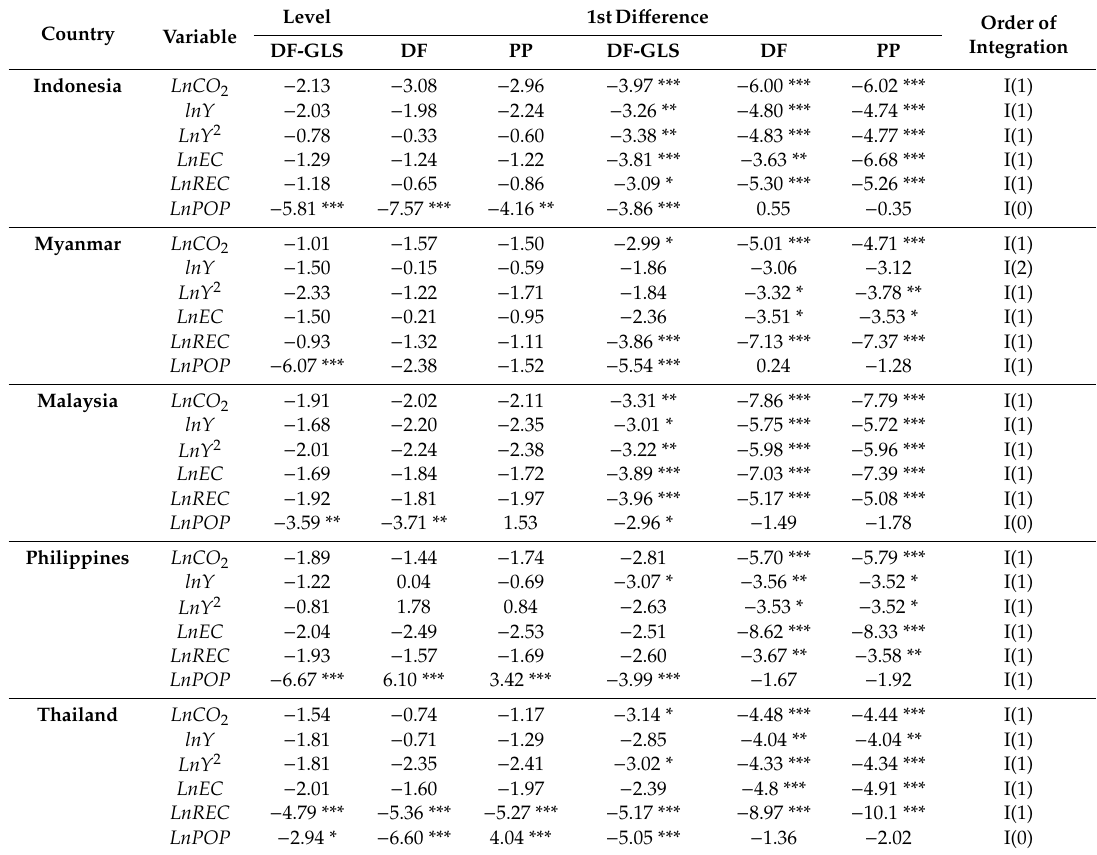
Table 2. The results of unit-root